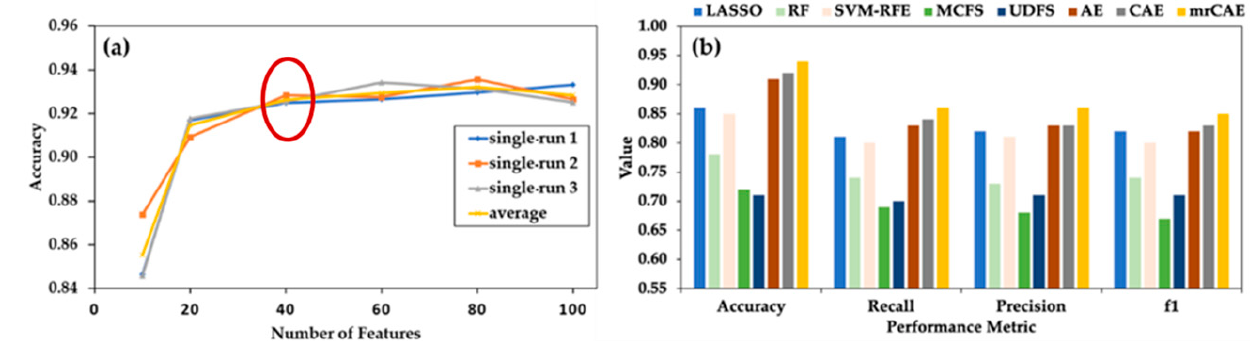
Figure 3. Comparing mrCAE with other feature selection approaches. ( a ) Behavior of single-run CAE to decide the number of features to be selected for comparison. CAE was run three times to select six sets of 10, 20, 40, 60, 80, and 100 features. “single avg” represents the average accuracy of three runs. ( b ) Classification performance using 40 features selected by LASSO, RF, SVM-RFE, MCFS, UDFS, AE, CAE and mrCAE. Note that, each approach selects 40 actual features except AE, which selectes 40 latent features.